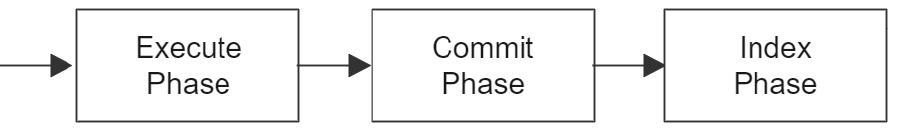
Figure 1. Execute–commit-index transaction processing